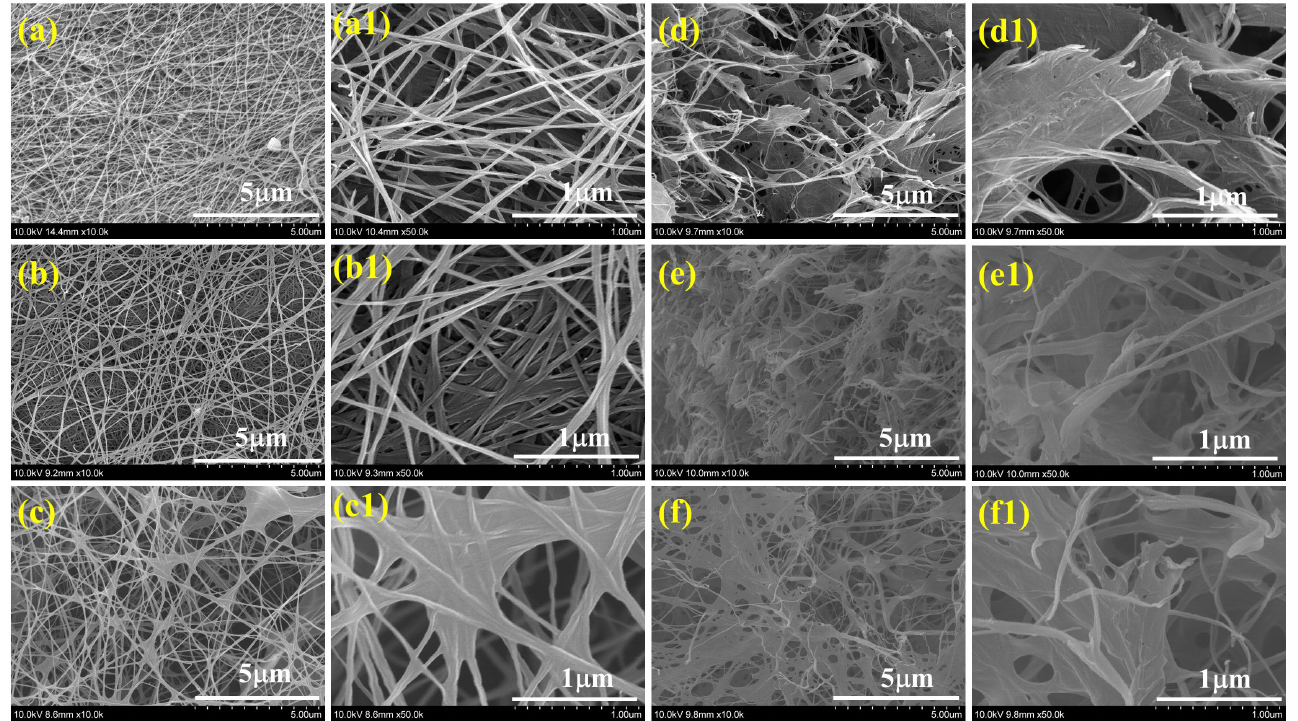
Figure 3. SEM images of ( a , a1 ) pure BC, ( b , b1 ) 0.1CMCS–BC, ( c , c1 ) 0.3CMCS–BC, ( d , d1 ) 0.5CMCS– BC, ( e , e1 ) 0.7CMCS–BC, ( f , f1 ) 1CMCS–BC hydrogels.